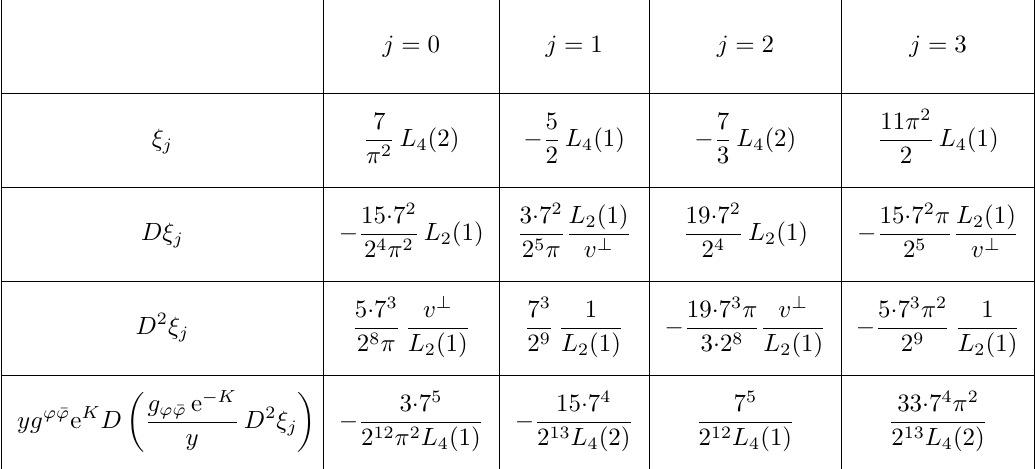
Table 5 . A table showing the values for the (cid:24) j and their covariant derivatives when ’ = (cid:0) 1 the (cid:12)rst two rows, the transcendentality degree for the j ’th entry is j , while for the third and fourth rows, it is 3 (cid:0) j